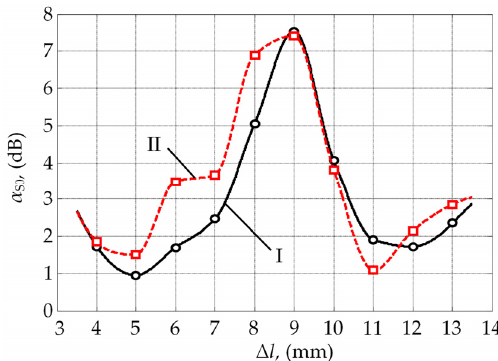
Figure 14. The transmission losses α S0 ( f ) of the S 0 mode obtained by I: using numerical simulation finite element (FE) method, II: experimental measuring.